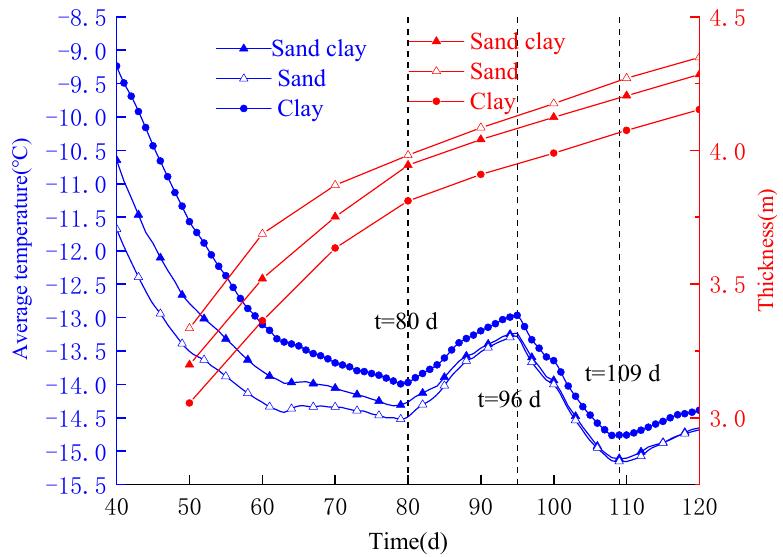
Figure 6. Variation in the thickness and average temperature of effective frozen wall.